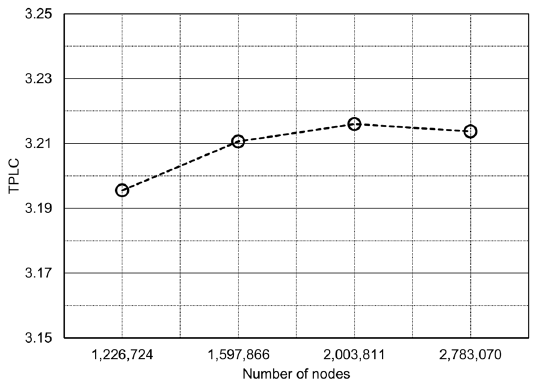
Figure 4. Comparison of the TPLC for different numbers of nodes.